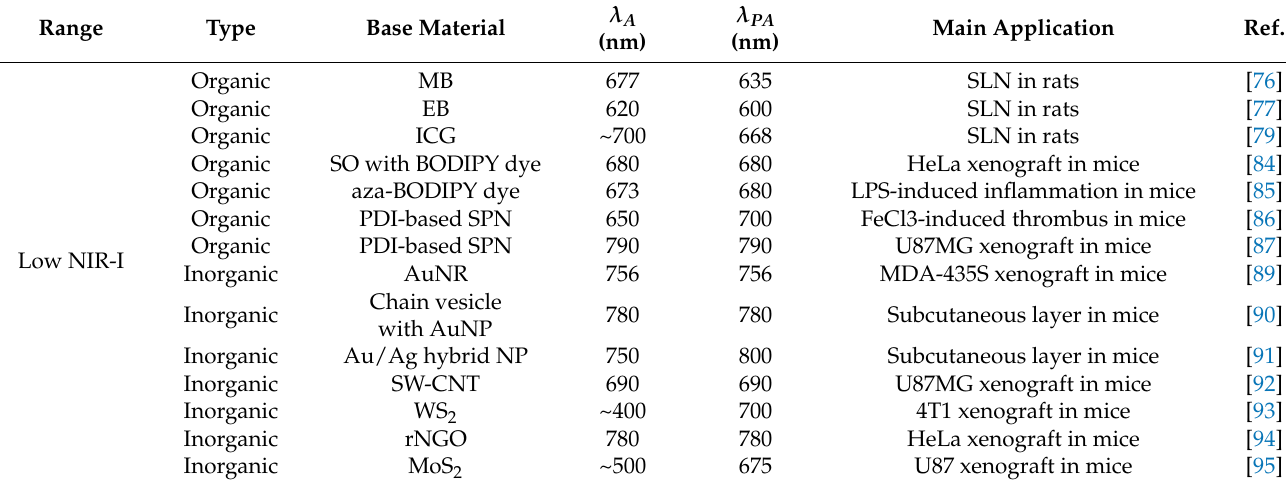
Table 2. Summary of PA contrast agents, including their optical absorption, PA signal generation, and applications. PA, photoacoustic; λ A , peak optical absorption wavelength; λ PA , excitation wavelength used for contrast-enhanced PA imaging; MB, methylene blue; EB, Evans blue; ICG, indocyanine green; SO, semiconducting oligomer; BODIPY, boron-dipyrromethene; SPN, semiconducting poly- mer nanoparticle; Au, gold; Ag, silver; AuNP, gold nanoparticle; AuNR, gold nanorod; AuNPr, gold nanoprism; SW-CNT, single-walled carbon nanotube; WS 2 , tungsten disulfide; rNGO, reduced nano-graphene oxide; Nc, naphthalocyanine; Pc, phthalocyanine; CyFaP, cyanine fluoroalkyl phos- phate; NiPNP, nickel dithiolene-based polymeric nanoparticle, MoS 2 , molybdenum disulfide; MoO 3 , molybdenum oxide; SLN, sentinel lymph node; GI, gastrointestinal; LPS, lipopolysaccharide.